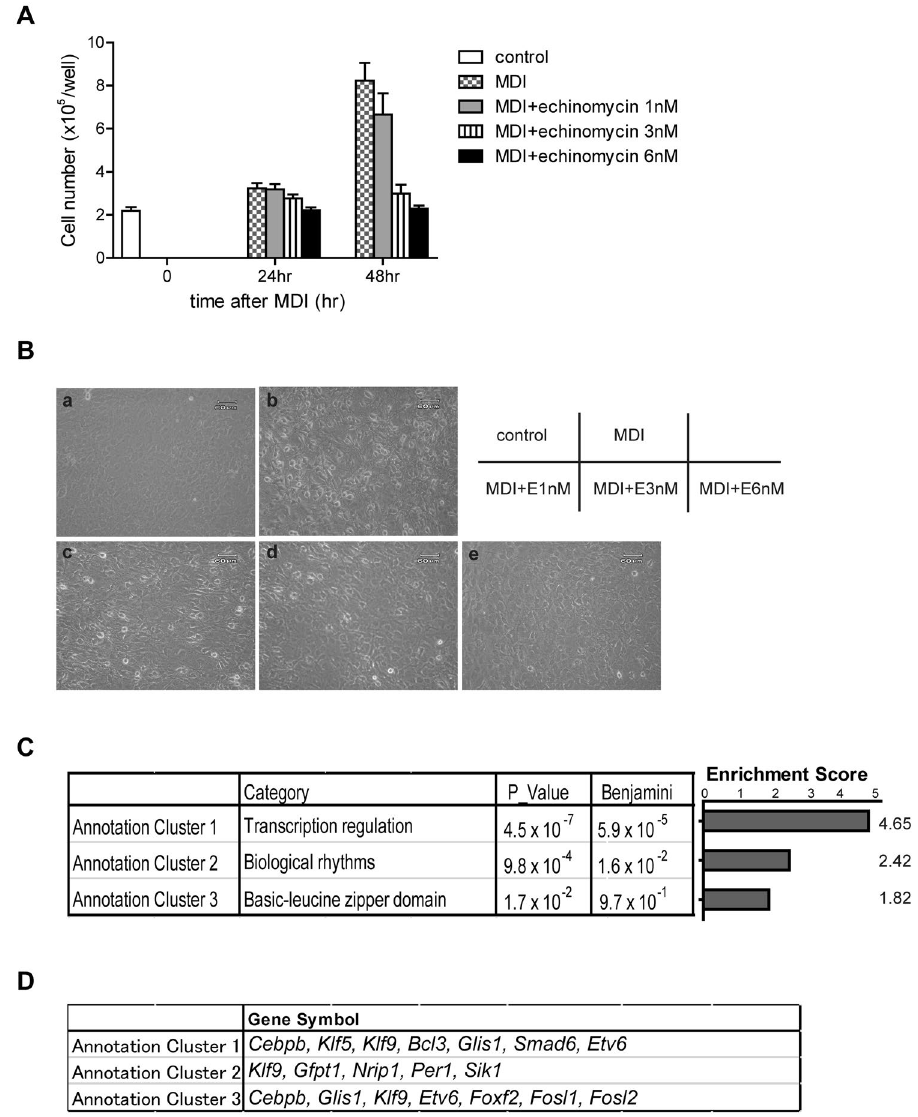
Figure 4. Echinomycin inhibits transcription and cell proliferation in 3T3-L1 cells. ( A ) Time-course cell counts were performed using trypan blue staining at 0, 24, and 48 hr after treatment with MDI + DMSO or MDI + echinomycin. Echinomycin inhibited cell proliferation in a dose-dependent manner. The data are the mean ± SEM of three independent experiments. ( B ) Microscopic view (20x) of 3T3-L1 cells at 24 hr after MDI ( + DMSO or echinomycin) treatment. ( C ) Significantly enriched functional clusters (defined as Enrichment Score > 1.3, equivalent to non-log scale 0.05.) as determined by gene ontology analysis of the 111 probes by DAVID (listed in Fig. 3D and Table S1). ( D ) The representative gene symbols of each group in Fig. 4C are